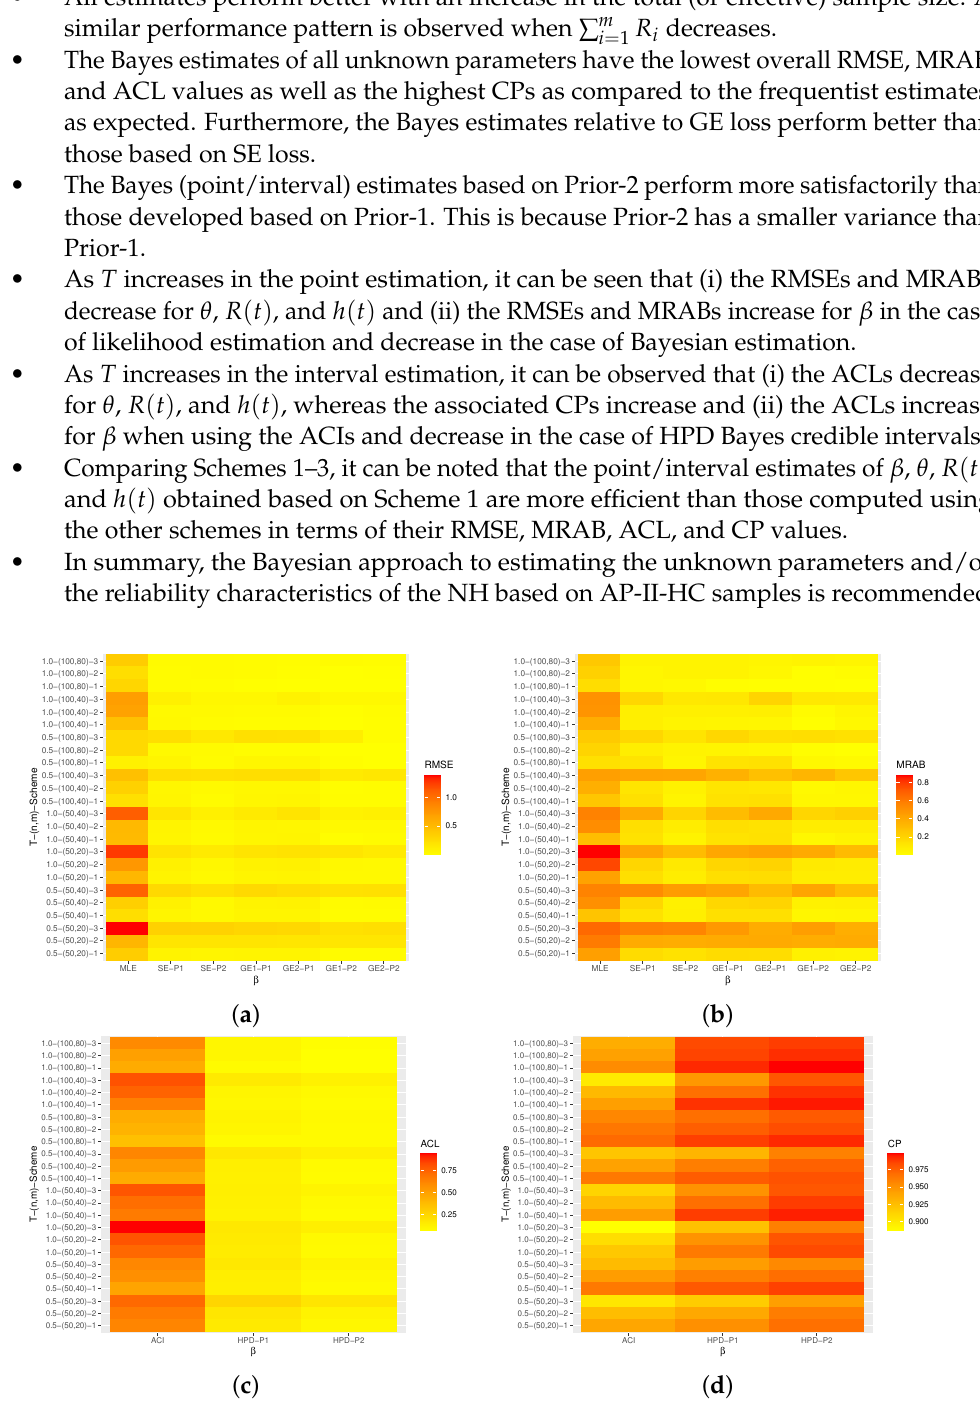
Figure 1. Heatmap plots for the estimation results of β . ( a ) RMSE. ( b ) MRAB. ( c ) ACL. ( d )